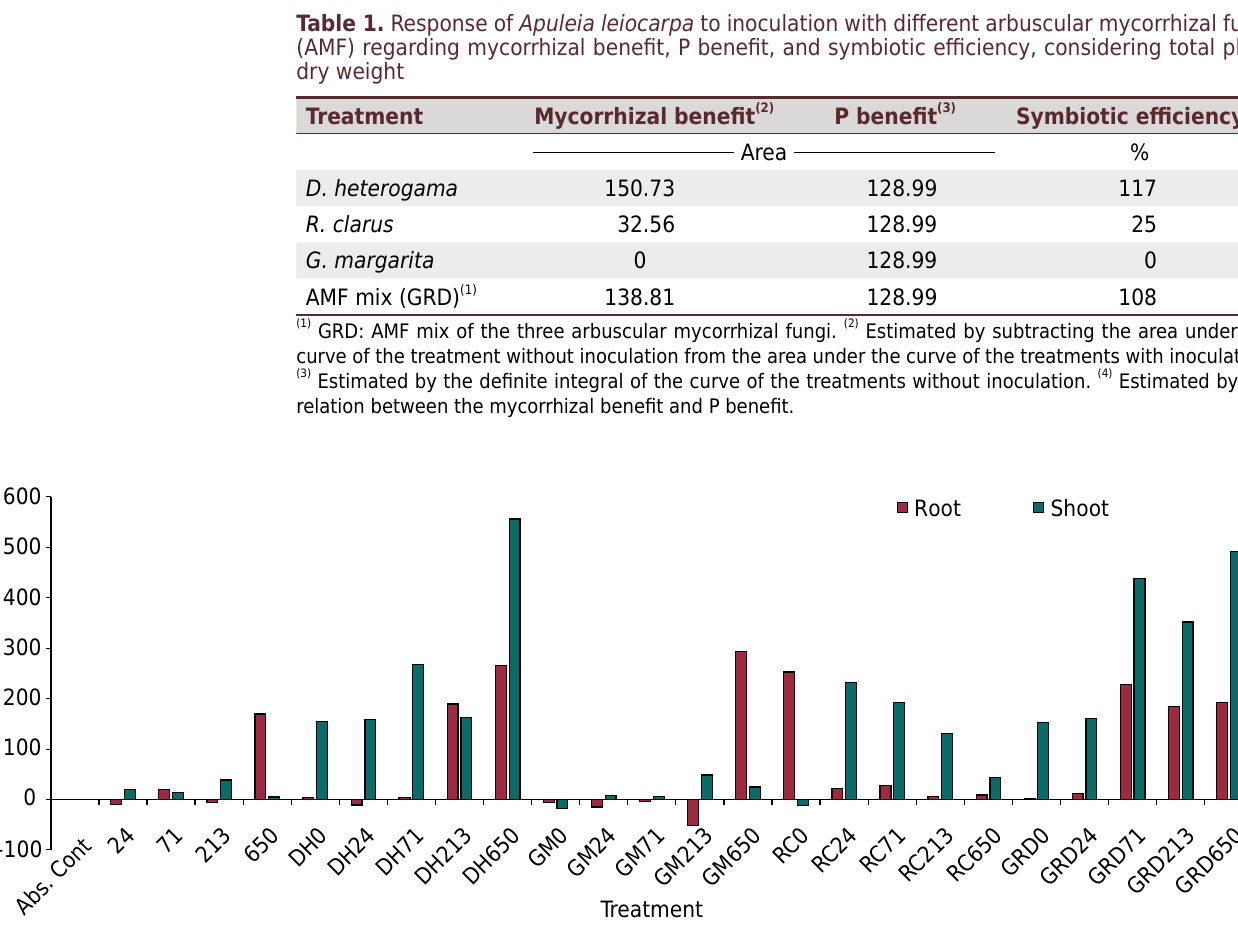
Figure 3. Relative increase (RI) of Apuleia leiocarpa seedlings due to inoculation with Dentiscutata heterogama (DH), Gigaspora margarita (GM), Rhizophagus clarus (RC), and GRD (DH+GM+RC) at different phosphorus rates (0, 24, 71, 213, and 650 mg kg -1 ), according to the variables SDW (shoot dry weight) and RDW (root dry